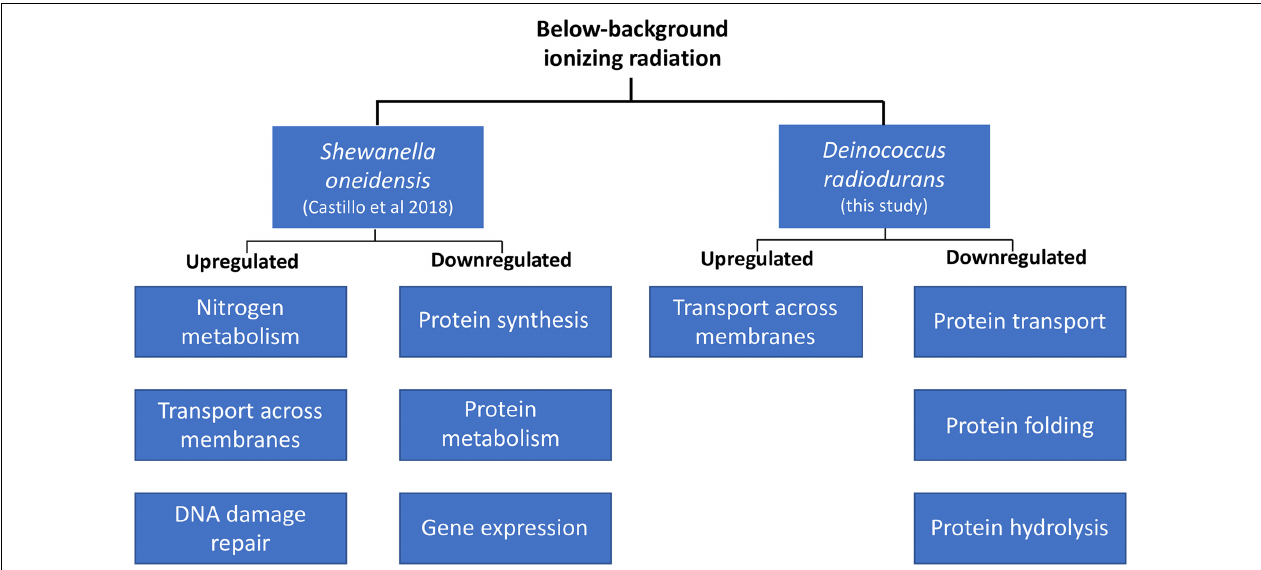
FIGURE 3 | Transcriptional regulation in D. radiodurans and Shewanella oneidensis in response to below-background ionizing radiation levels based on biological processes.